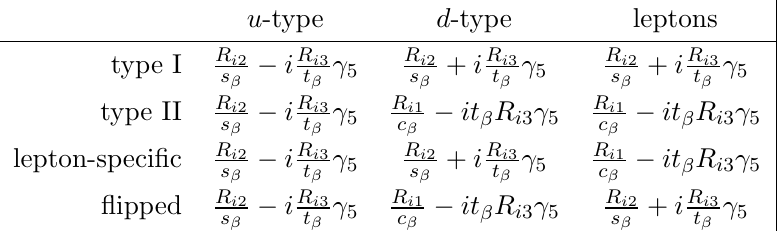
Table 2 . Coupling coe(cid:14)cients of the Yukawa couplings of the Higgs bosons H i in the C2HDM. The expressions correspond to [ c e ( H i ff ) + ic o ( H i ff ) (cid:13) 5 ] from eq.